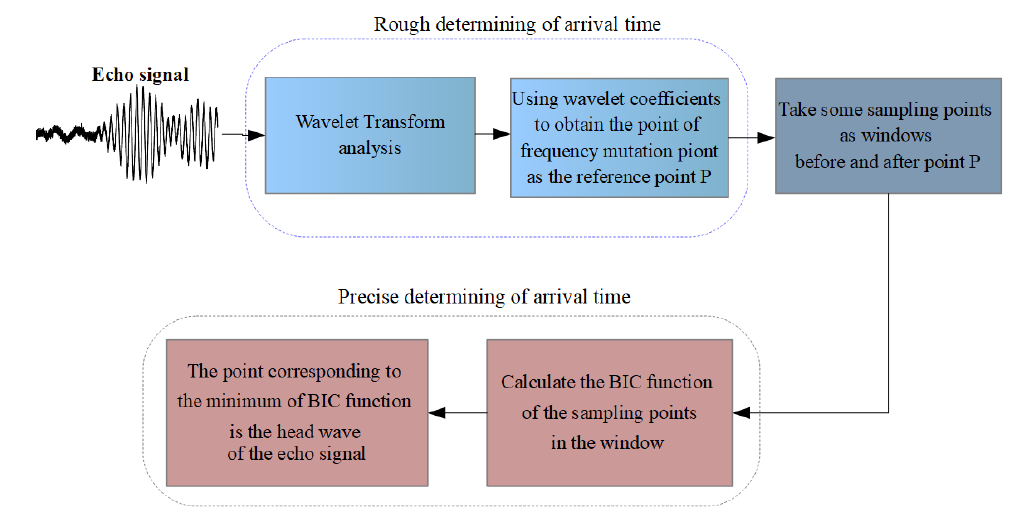
Figure 4. Time-frequency distribution based on MWT: ( a ) time window; ( b ) BIC function.